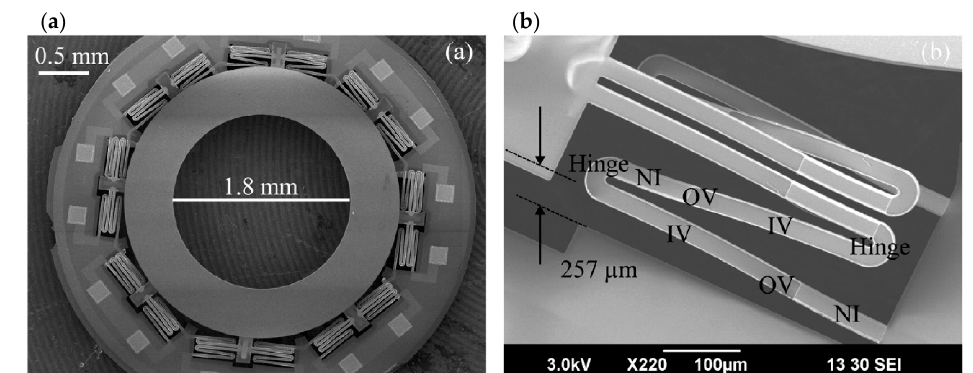
Figure 25. SEMs of the microlens scanner: ( a ) top view of complete structure and ( b ) focus on one of eight inverted-series-connected (ISC) actuators where the silicon beam is suspended 257 µm above the outer silicon frame (Figures from [69]).